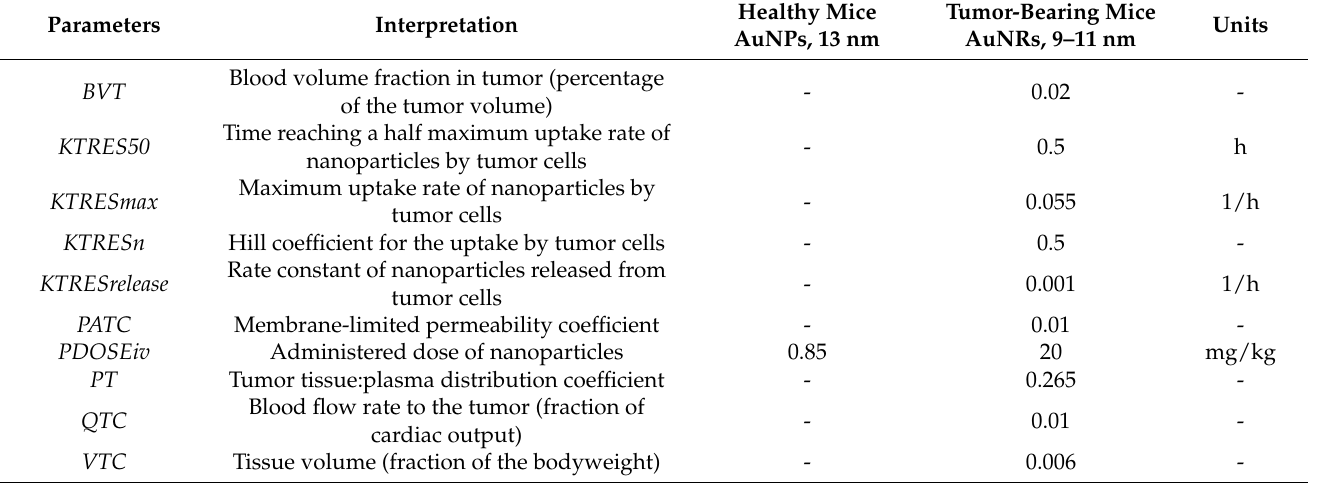
Table 4. Values of the model parameters to simulate cases of distribution of the gold nanoparticles (AuNPs, 13 nm) in healthy mice and of the gold nanorods (AuNRs, 9–11 nm) in tumor-bearing